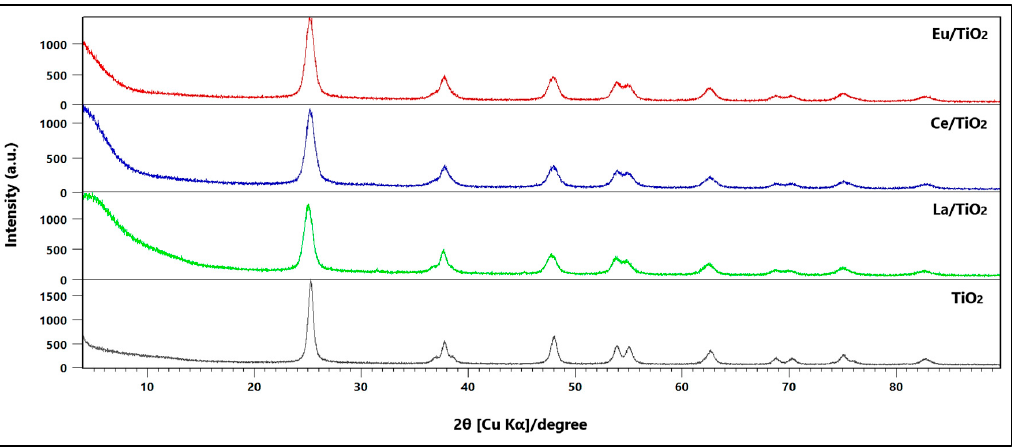
Figure 1. Comparison of XRD patterns of TiO 2 , La/TiO 2 , Ce/TiO 2 , and Eu/TiO 2 nanoparticles.